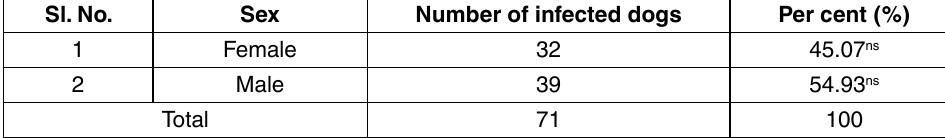
table 2. Sex wise occurrence of bacterial dermatitis in dogs sl. No.